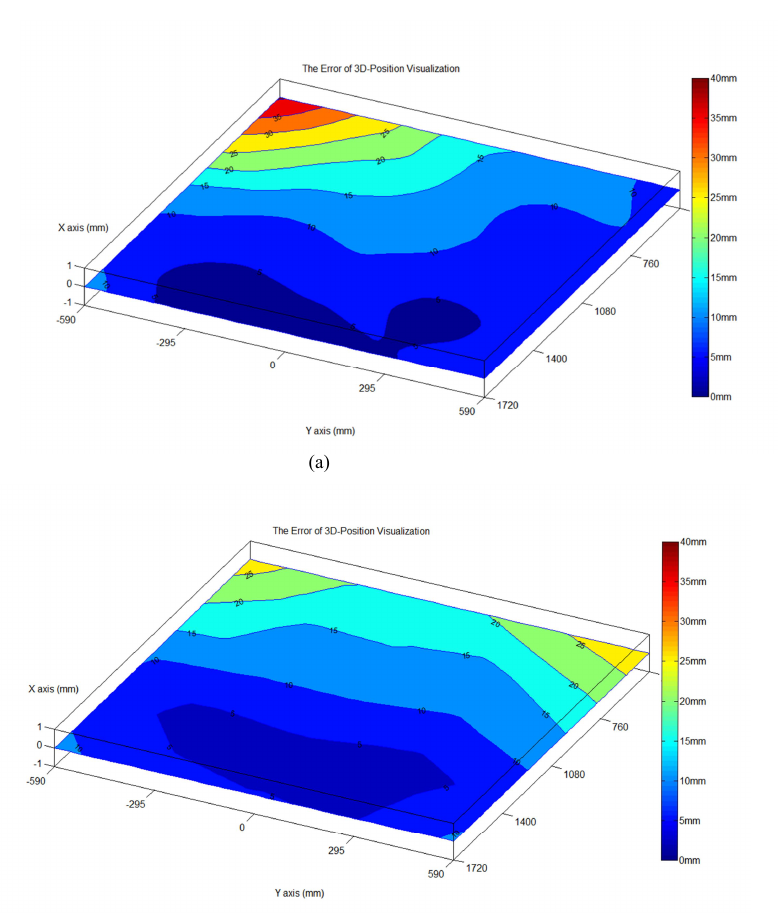
Figure 9. Distributions of the errors ( a ) using the right camera (camera#1) and the left camera (camera#2); ( b ) using the left camera (camera#2) and the auxiliary camera